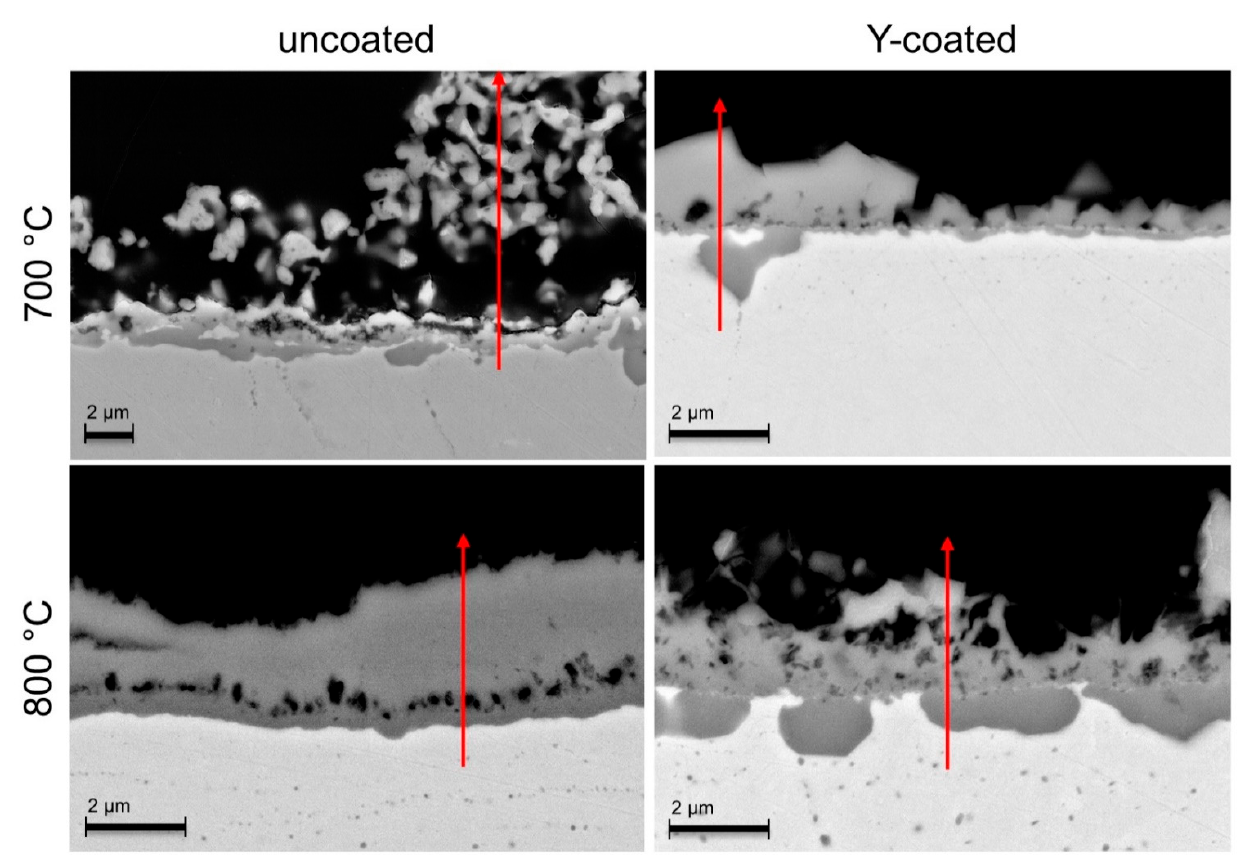
Figure 11. Average oxide scale thicknesses (including chromium-rich oxides) for Crofer 22 APU ( left ) and AISI 441 ( right ) samples tested in oxidizing atmosphere with standard deviations.